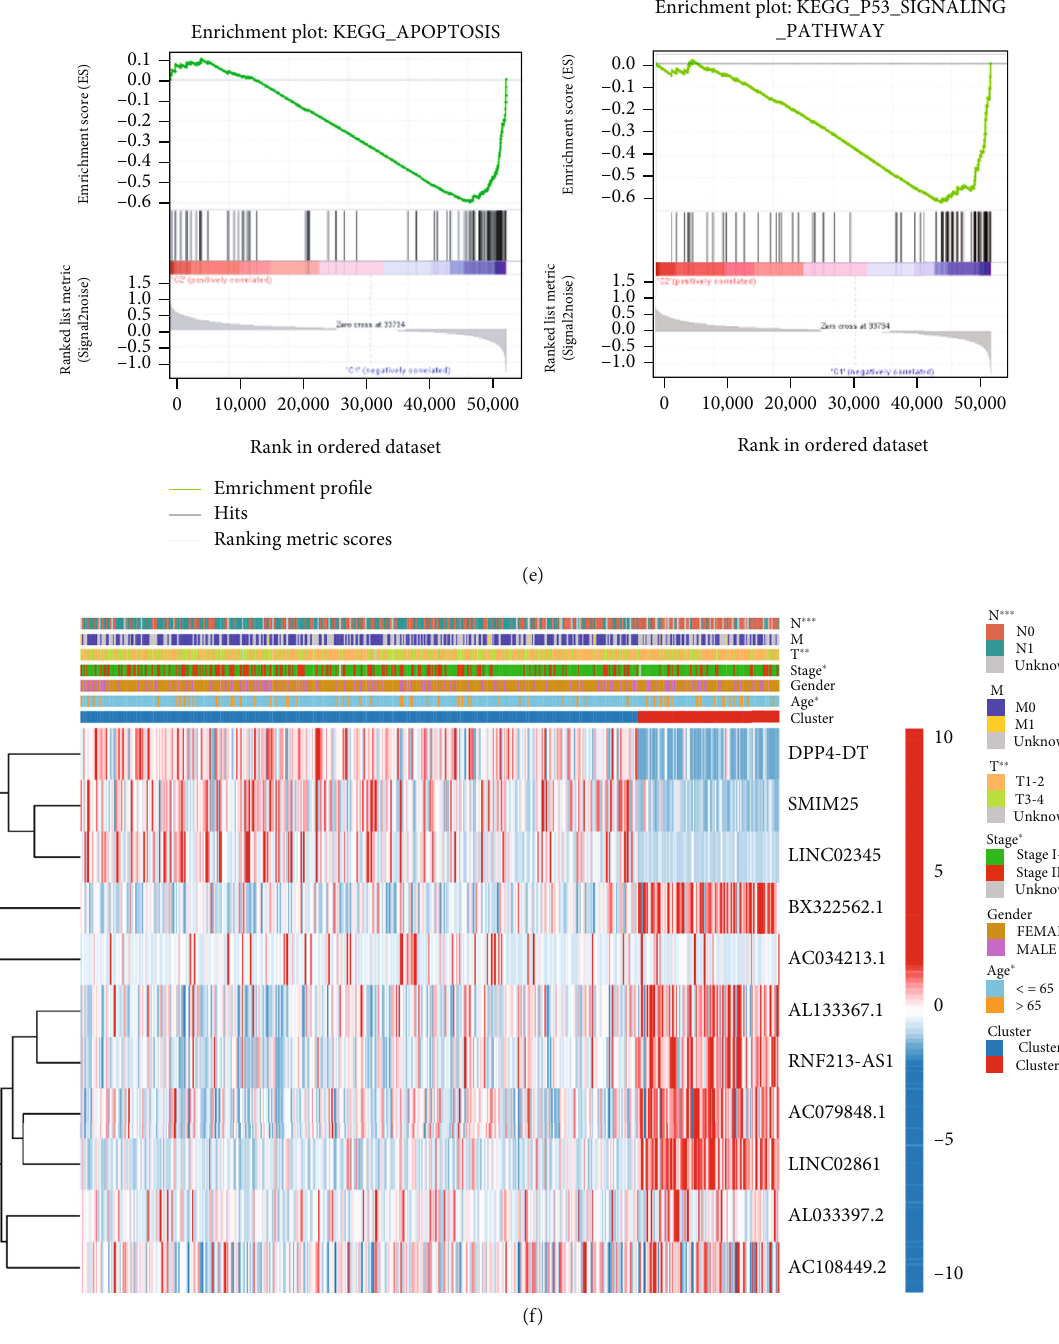
Figure 2: Unsupervised cluster analysis of Ferr-associated prognostic lncRNAs. (a) Interactions among lncRNAs in TC. The line connecting the genes represents their interaction, with the line thickness indicating the strength of the association between genes. Green and pink represent negative and positive correlations, respectively. (b) Consensus clustering matrix for k = 2 . (c) K-M survival curves of overall survival (OS) in C1 and C2 clusters. (d) PCA analysis shows a discriminable dimension between the two clusters. (e) GSEA results show signi fi cant enrichment of apoptosis pathway and p53 pathway in cluster1. (f) Di ff erences in clinicopathologic features and expression levels of lncRNAs between the two